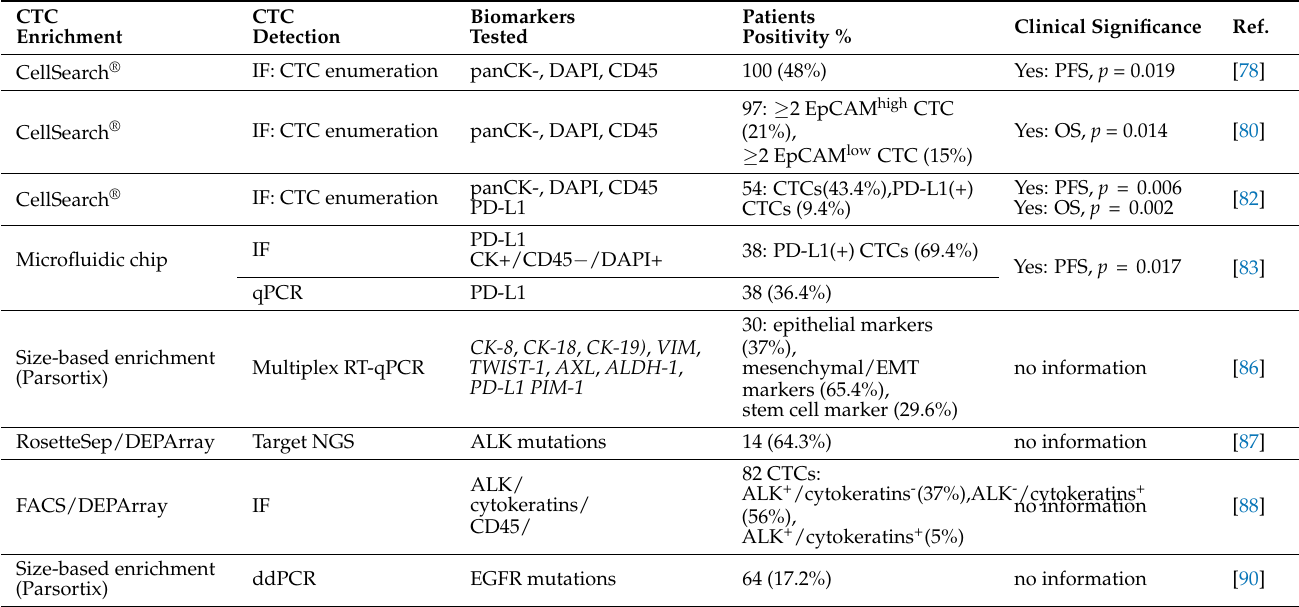
Table 3. Overview of clinical studies in CTCs on NSCLC